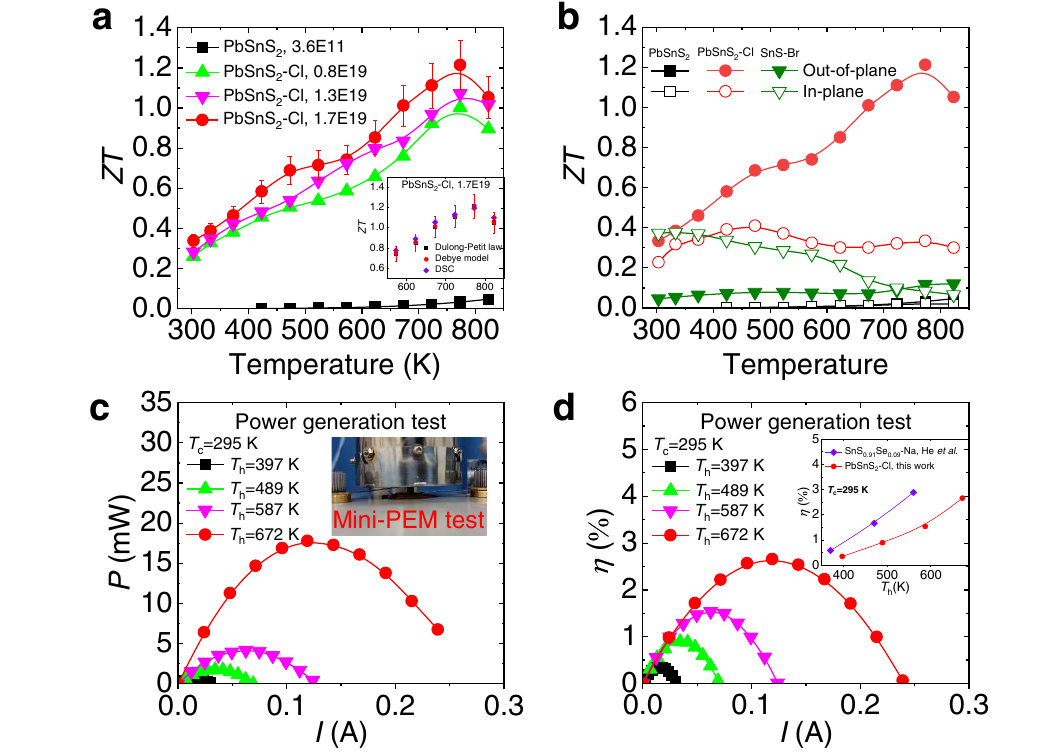
Fig. 6 | Thermoelectric performance and single-leg power generation ef fi - ciency. a ZT values of undoped and Cl doped PbSnS 2 crystals, the inset shows ZT valuesoftheoptimalCldopedPbSnS 2 crystalcalculatedaccordingtoDulong-Petit law, Debye model and the experimental DSC data. Error bars are ±10%. b The comparison of ZT values between PbSnS 2 and SnS crystals 23,24 along in-plane and